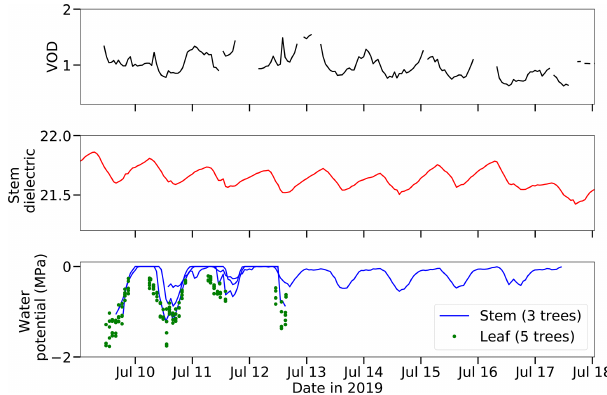
Figure 3. VOD, the stem xylem dielectric constant at 70MHz, and plant water potential during the intensive observation period. Note that stem water potential and leaf water potential were measured on different sets of